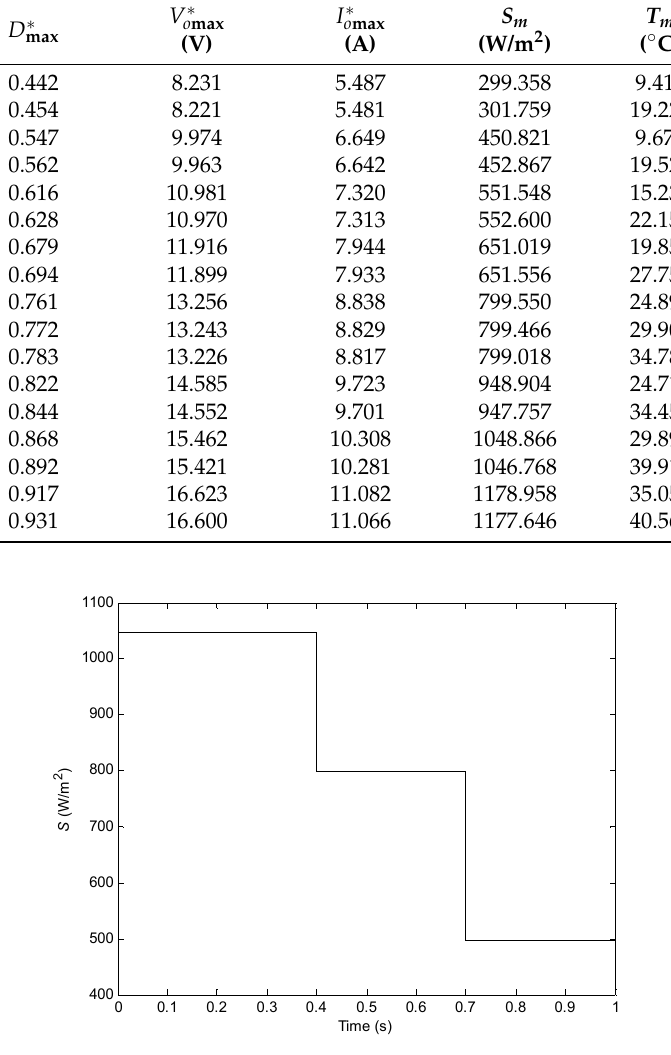
Figure 12. Assumed irradiance curve in first simulation